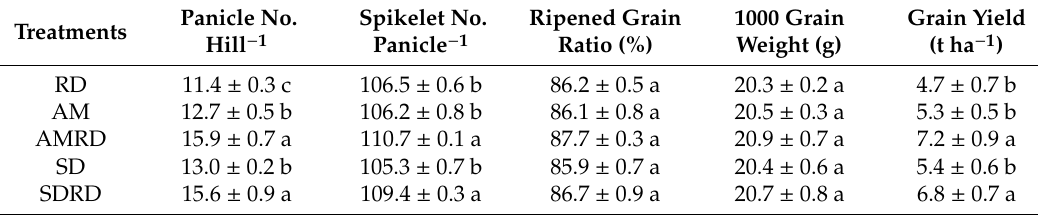
Table 4. Description of grain yield and its components in di ff erent treatments of fertilizer application. Panicle No. Treatments Hill − 1